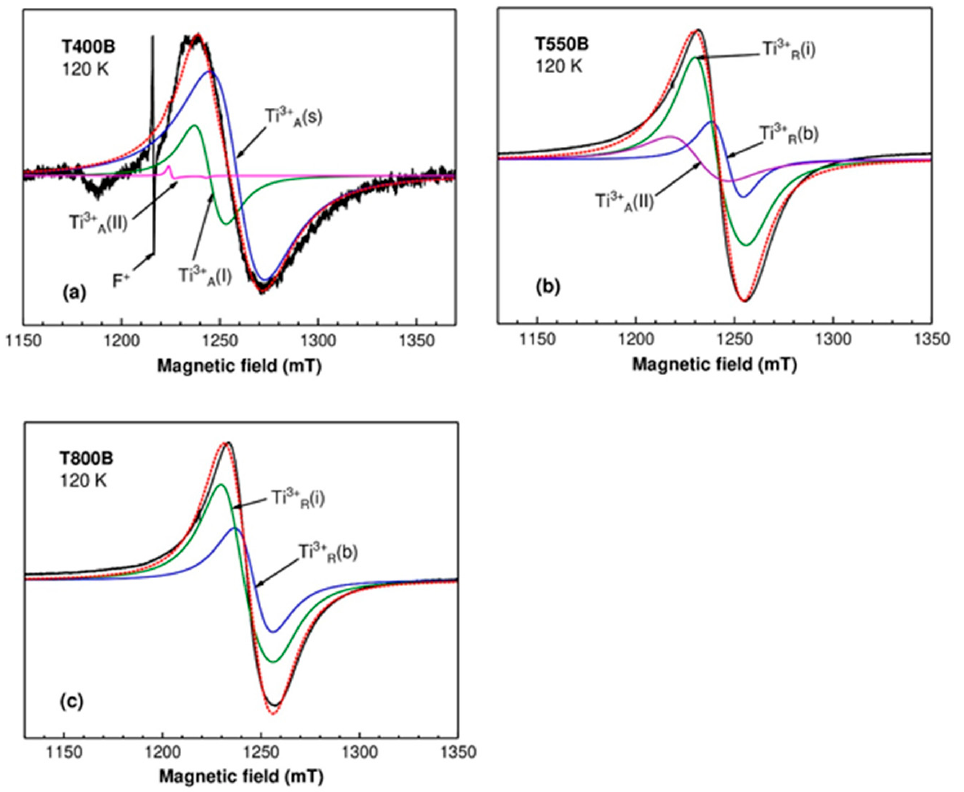
Figure 7. Experimental (solid black line) spectra of the T400B ( a ), T550B ( b ), and T800B ( c ) samples at 120 K. The simulated spectra (red dotted lines) are the sum of the calculated spectra of the different Ti 3+ centers. Table 2. EPR parameters of the Ti 3+ centers in anatase and rutile.